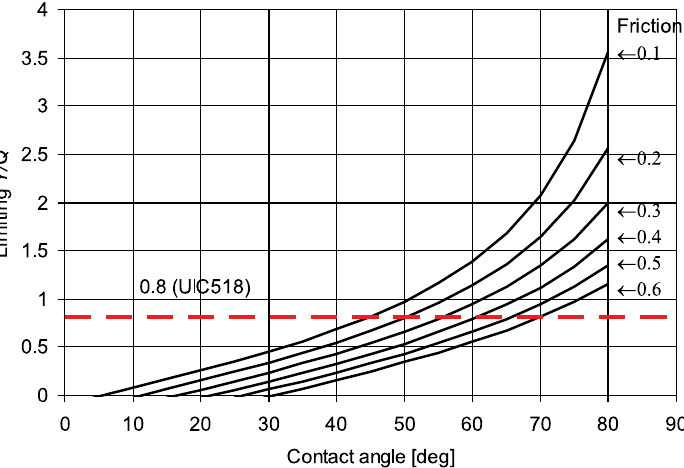
Figure 4. Dependence of the function ( Y/Q ) on the coefficient of friction μ and the flange angle γ according to UIC 518.